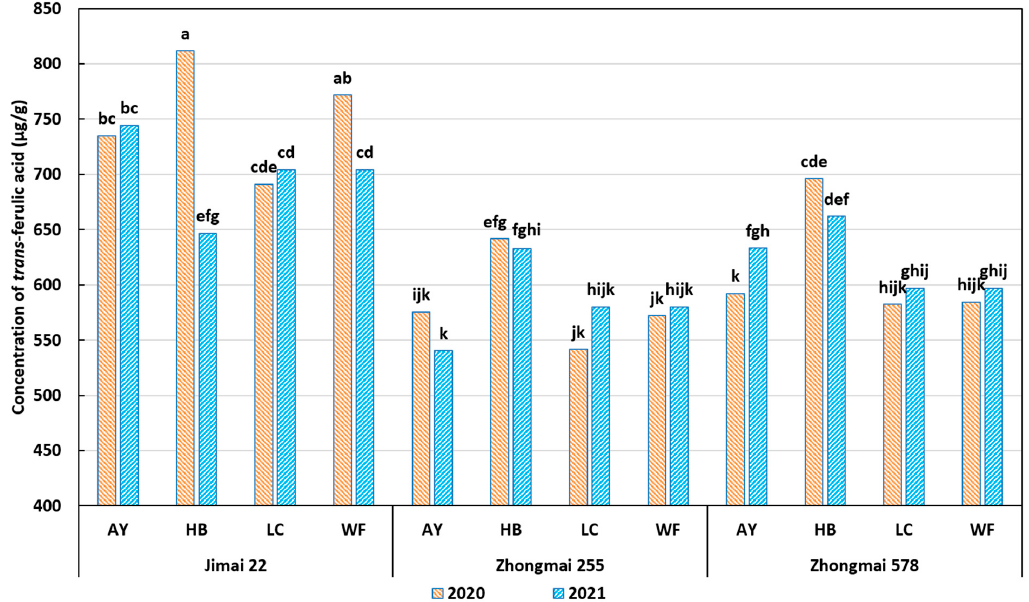
Figure 1. Effect of L*V*Y on concentration of trans -ferulic acid. L: location; V: variety; Y: year; AY: Anyang; HB: Huaibei; LC: Liaocheng; WF: Weifang. Values with no letter in common are considered significantly different ( p < 0.05).